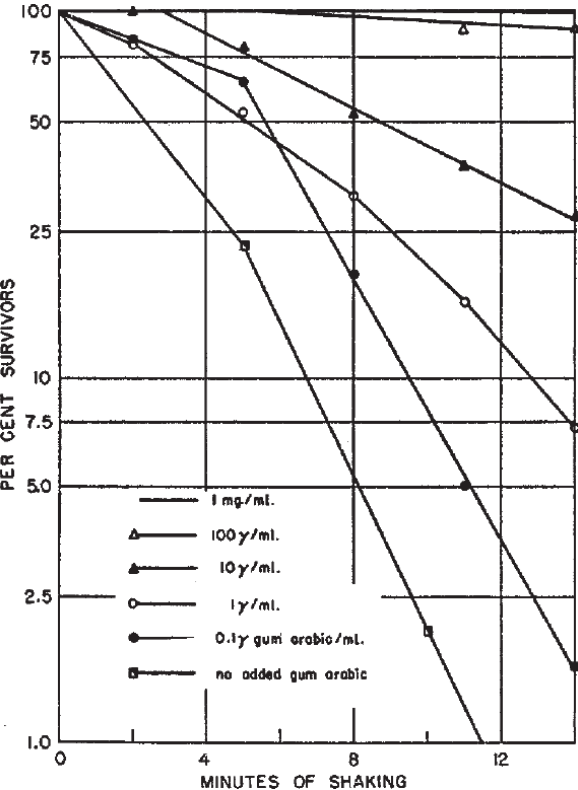
Figure. 4. The inactivation of phage T 5 , shaken in the presence of various amounts of gum